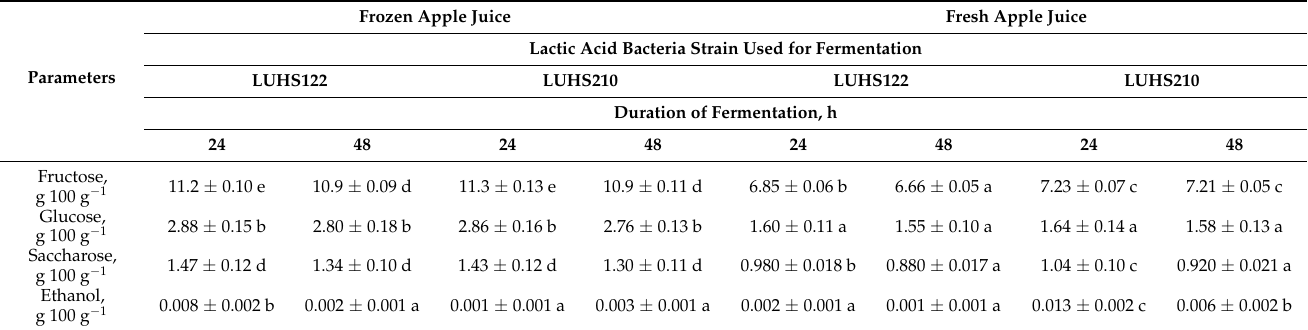
Table 7. Saccharide and ethanol concentrations in fermented apple juice.